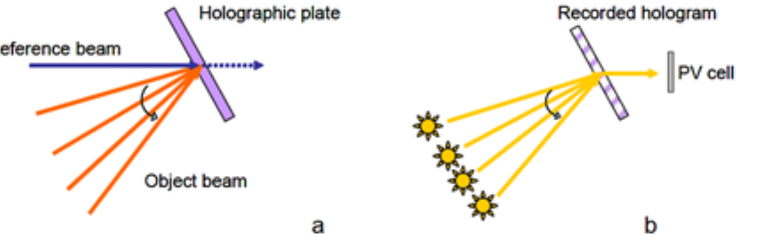
Figure 9. ( a ) HOE recording for passive solar tracking. ( b ) Schematic behaviour of holographic system for passive solar tracking.